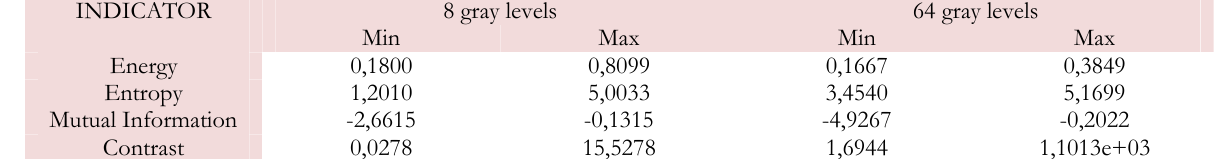
Figure 27: Contrast 8 gray levels.